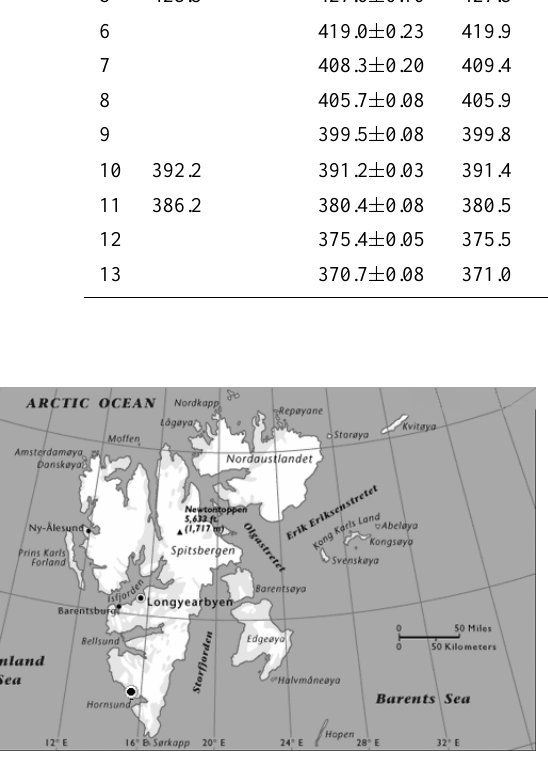
Fig. 1. Map of Spitsbergen Archipelago with position of the Russian-Swedish expedition base Konstantinovka at Hornsund.